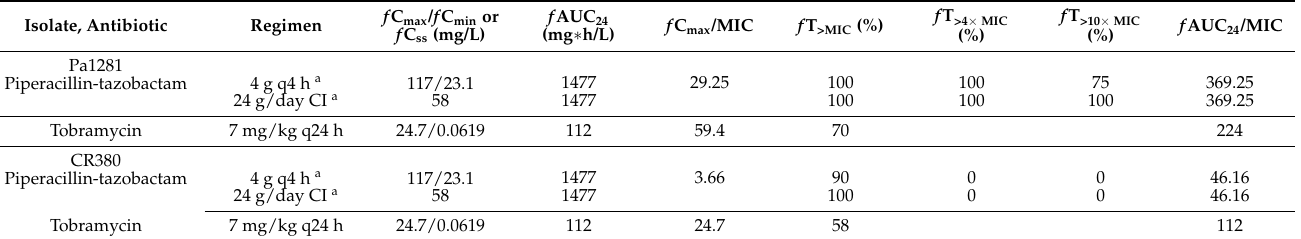
Table 3. Clinically representative exposures and pharmacokinetic/pharmacodynamic indices for piperacillin and tobramycin against Pa1281 and CR380 following different dosage